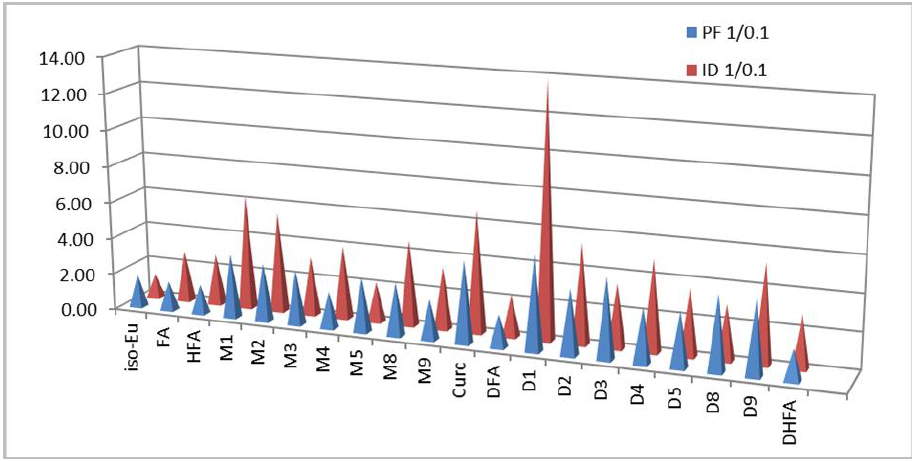
Figure 2. Effect of concentration for selected monomers and dimers.